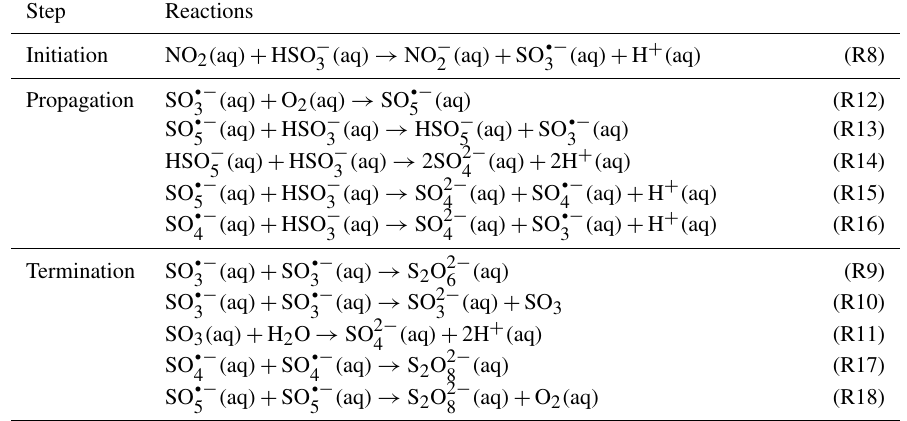
Table 2. Summary of the mechanism of the reaction S(IV) with O 2 / NO 2 . Step